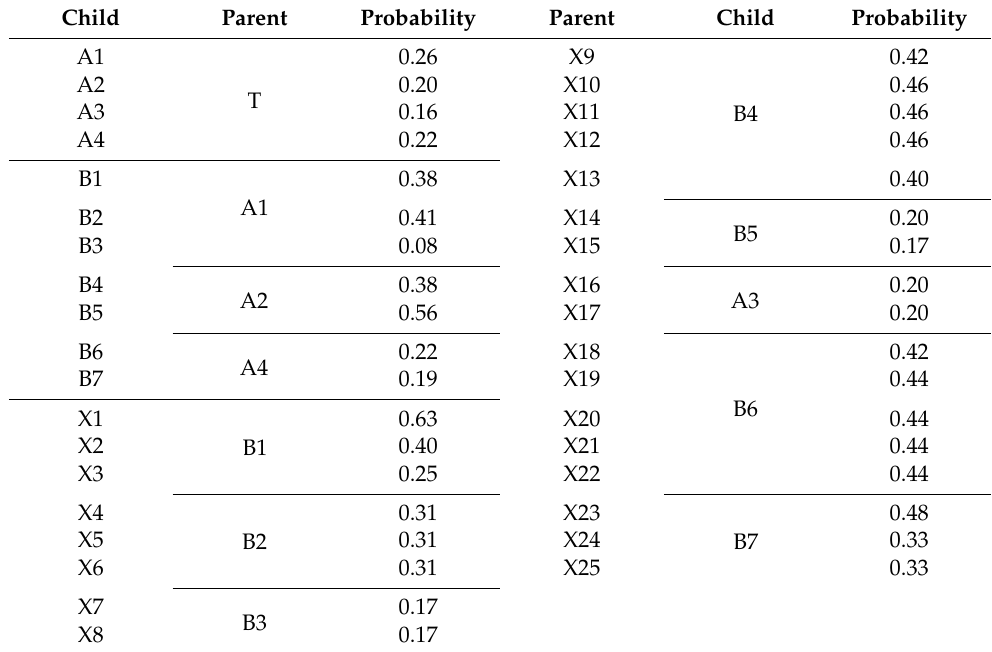
Table 5. Estimated path probabilities on the condition of “strength of